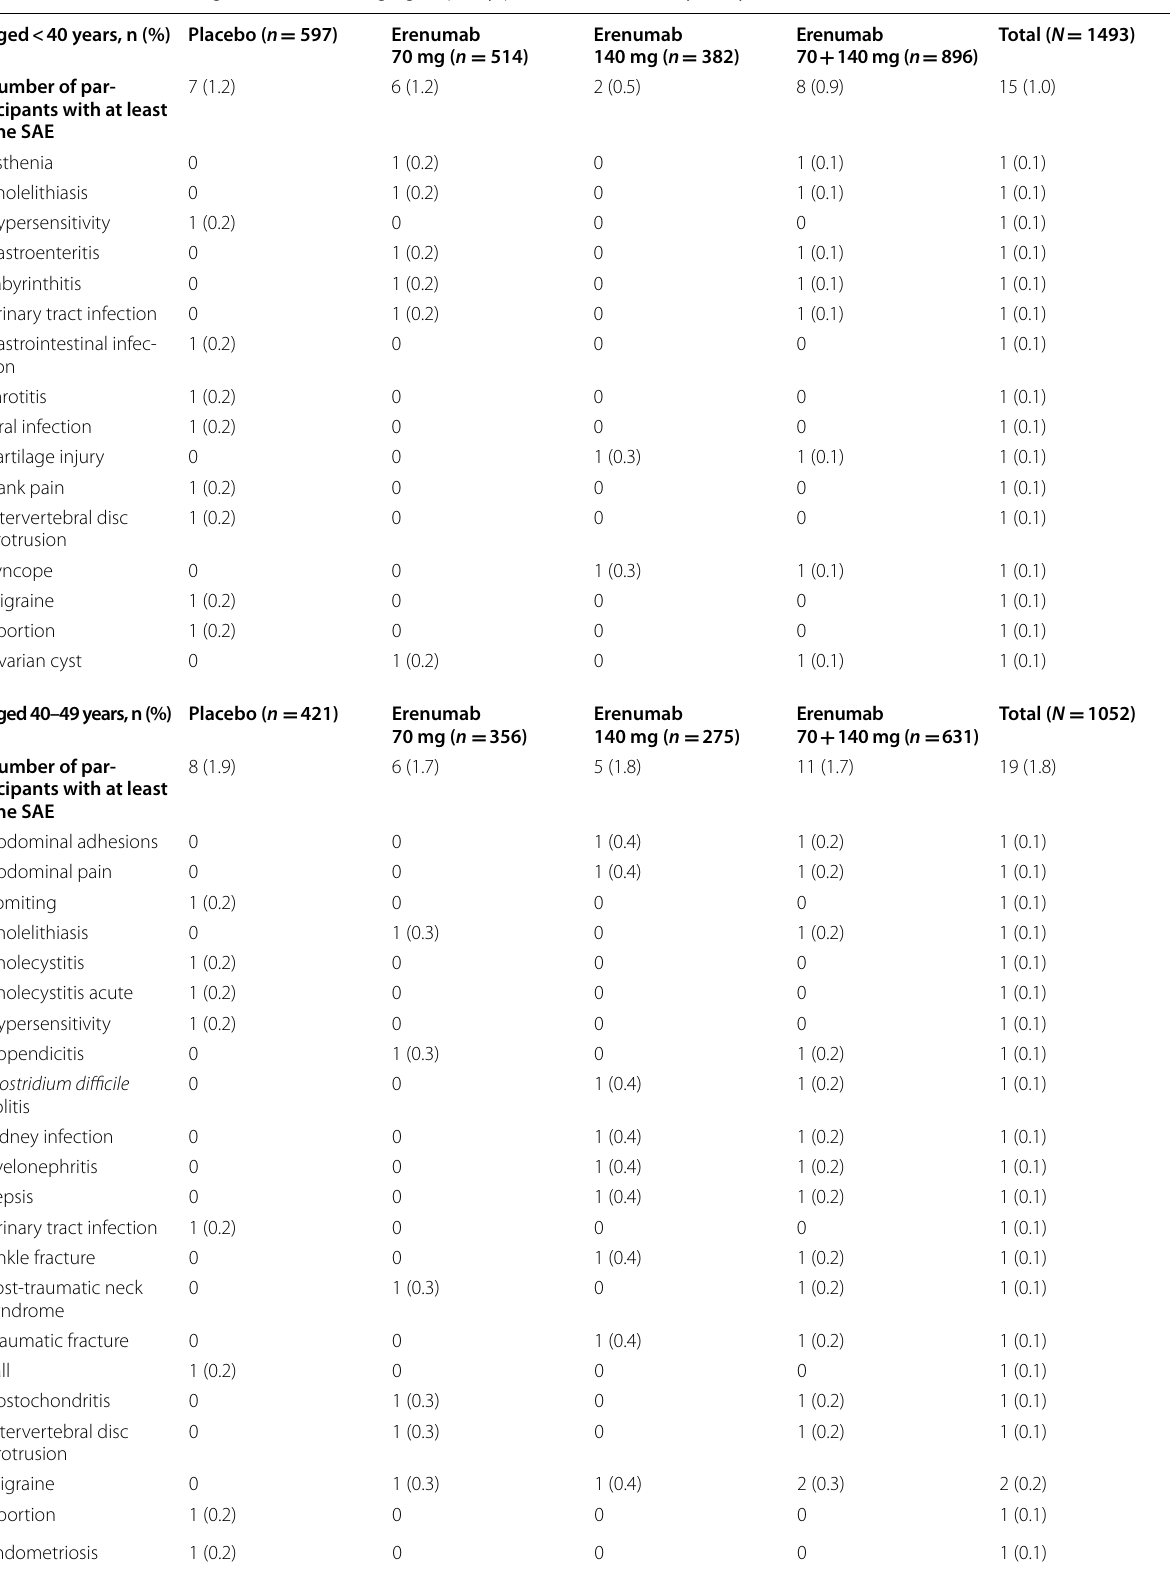
Table 4 Treatment-emergent SAEs across age groups, by preferred term (safety analysis set) Aged < 40 years, n (%) Placebo ( n =